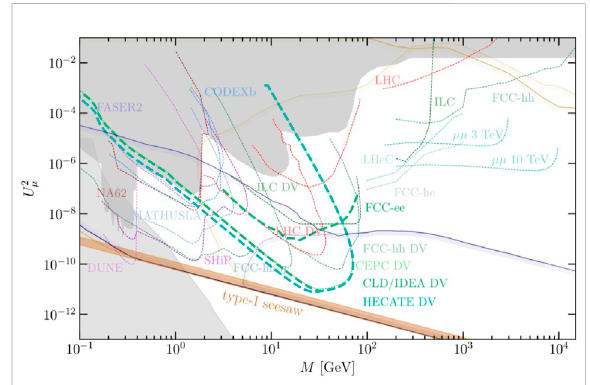
FIGURE 4 Comparison of the parameter regions in which four events (bold lines) and one event (non-bold lines) are expected in the IDEA/CLD detector or HECATE, with the same conventions and assumptions as in Figure